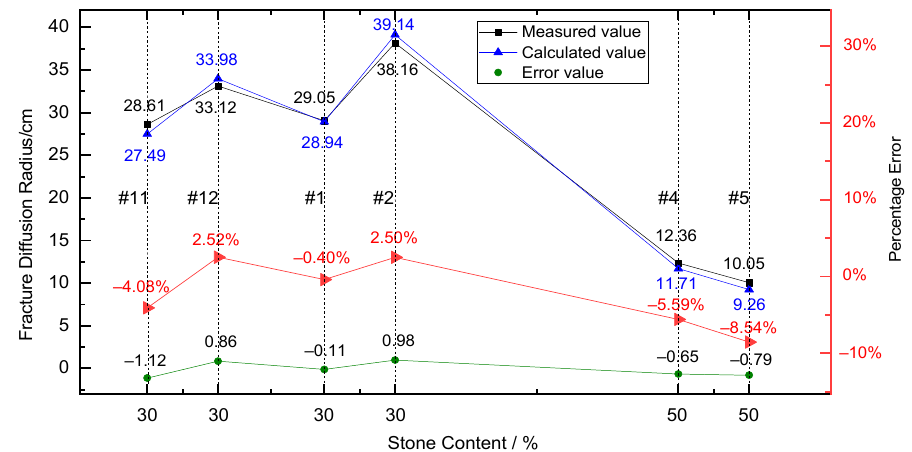
Figure 18. Comparison of calculated values of diffusion radius and measured values.